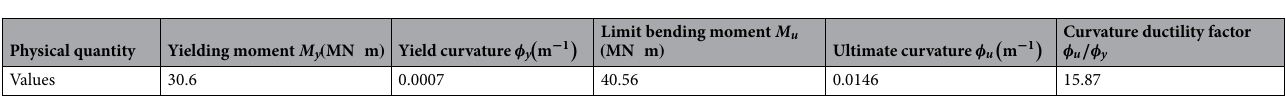
Table 1. Parameters for bending